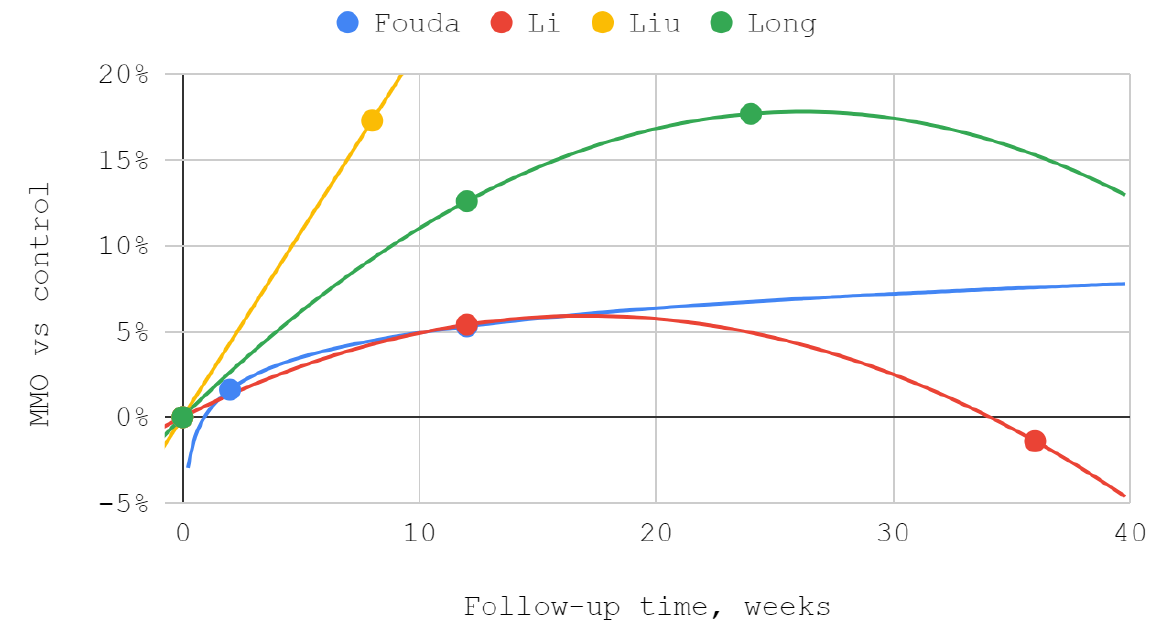
Figure 9. The efficiency of inferior versus superior compartment TMJ treatment in maximum mouth opening (MMO) domain over time.